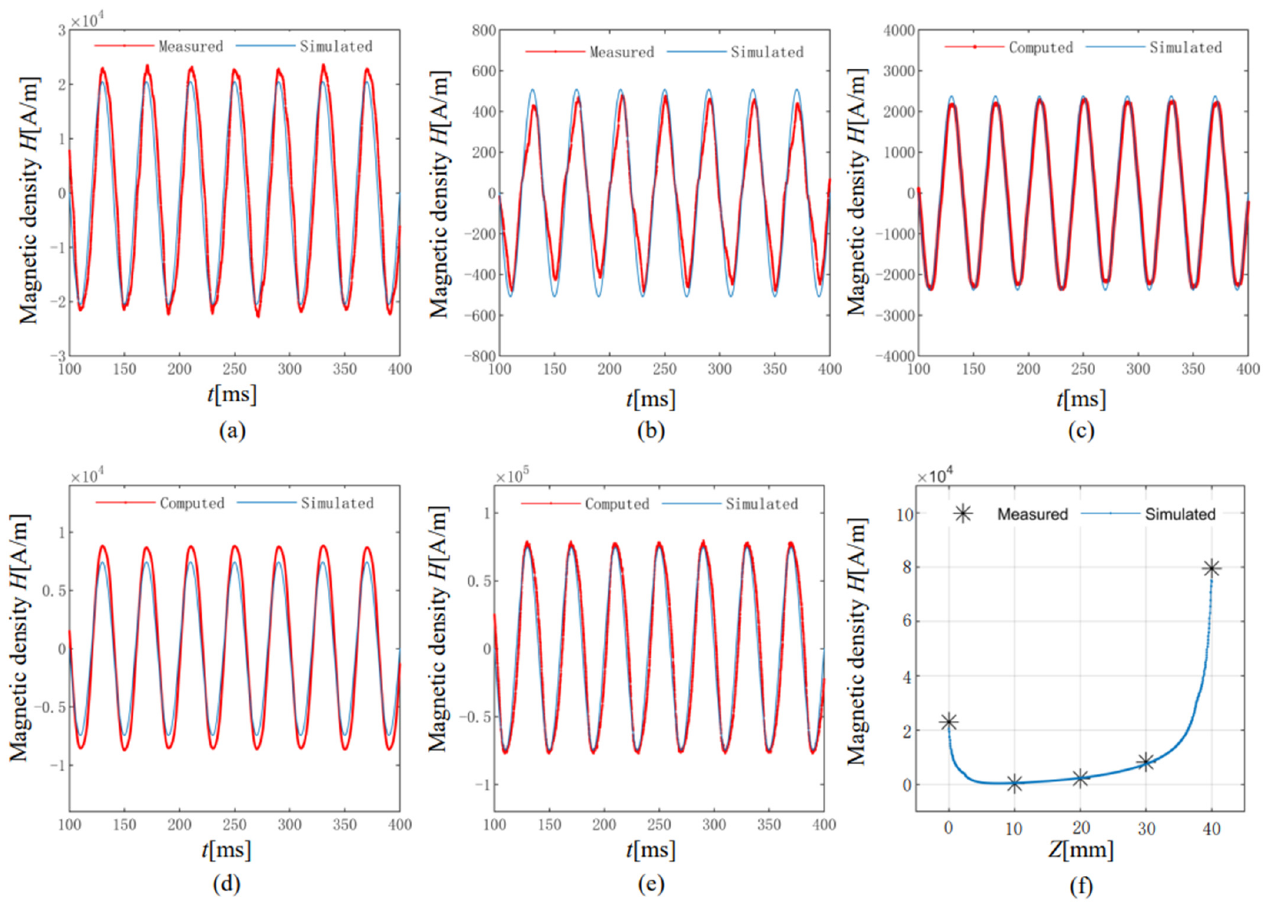
Figure 23. Comparison of magnetic field intensity between simulation and experiment: ( a ) Z = 0 mm; ( b ) Z = 10 mm; ( c ) Z = 20 mm; ( d ) Z = 30 mm; ( e ) Z = 40 mm; ( f ) Z varied from 0 mm to 40 mm.